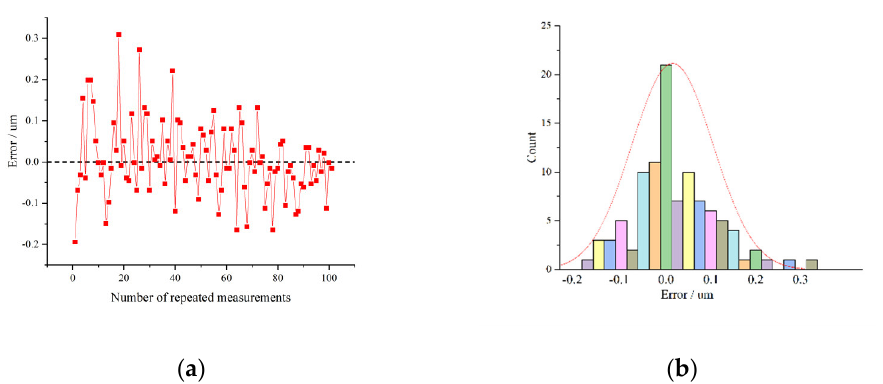
Figure 17. Errors of repeated measurement. ( a ) Repetition errors distribution; ( b ) Repetition errors histogram.